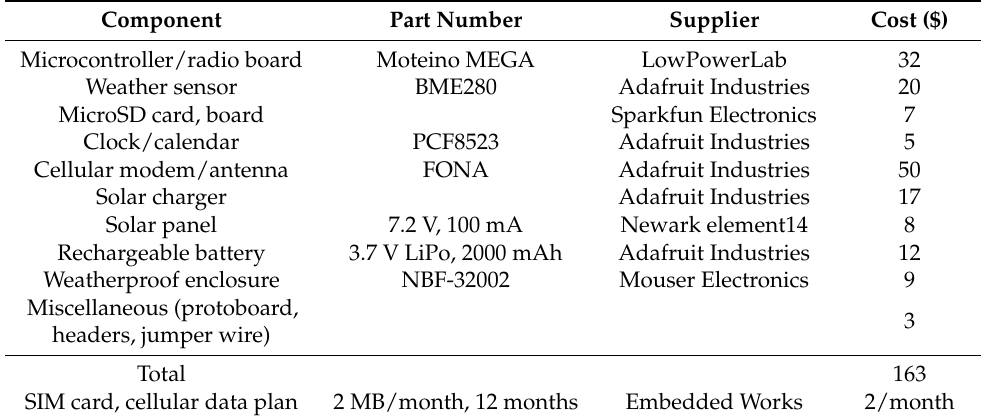
Table 2. List of materials for cellular